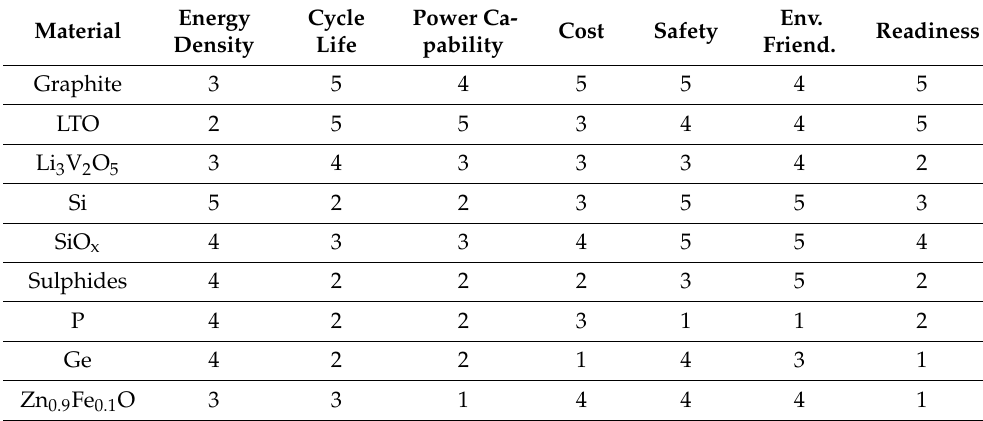
Table 2. Characteristics and evaluation of the different anode materials described. The minimum grade is 1 and the maximum is 5. Env. Friend. refers to environmental